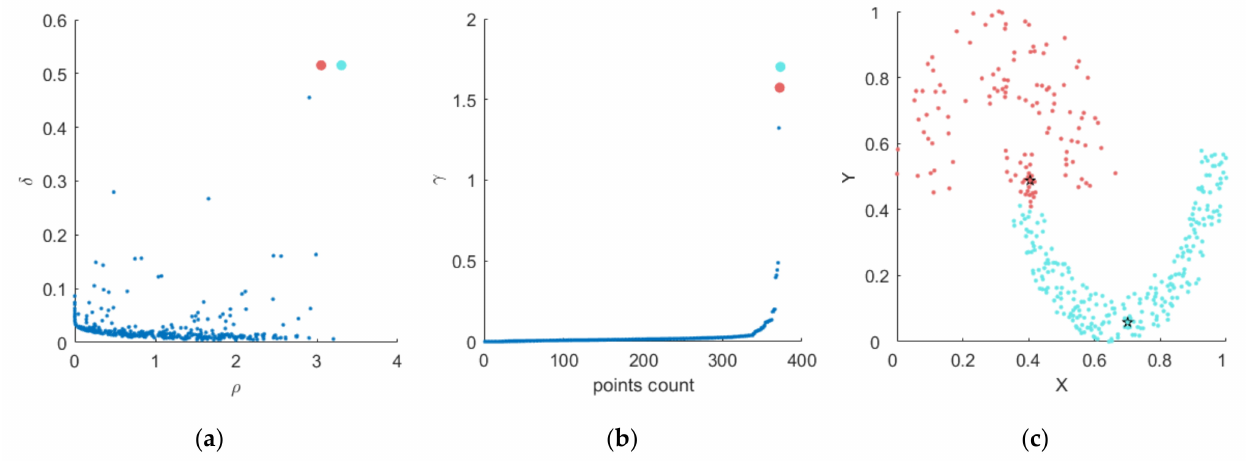
Figure 1. Best clustering result of DPC on Jain (percent = 0.3) ( a ) decision graph with ρ as x -axis and δ as y -axis; ( b ) distribution of γ value with points count as x -axis and γ as y -axis; ( c ) clustering result.